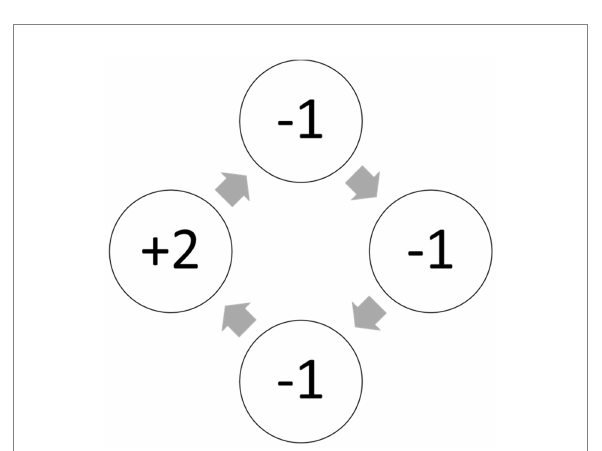
FIGURE 7 An example of a 4-state Markov chain that could determine the payoff from Top in Figure